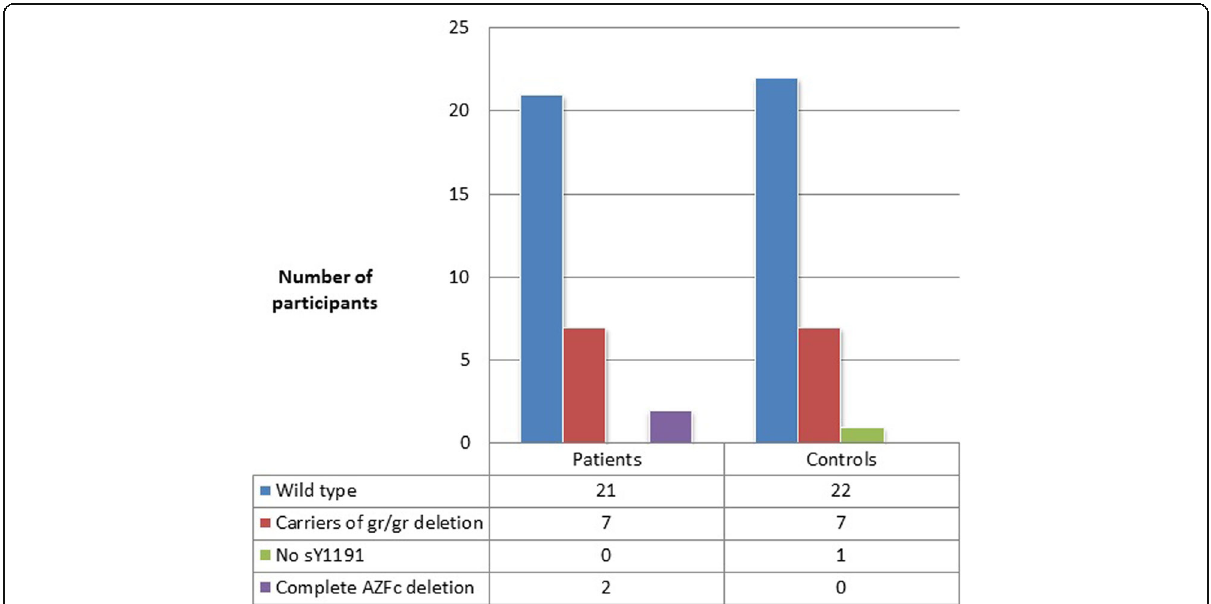
Fig. 2 Prevalence distribution of the genotypes of the participants for the gr/gr